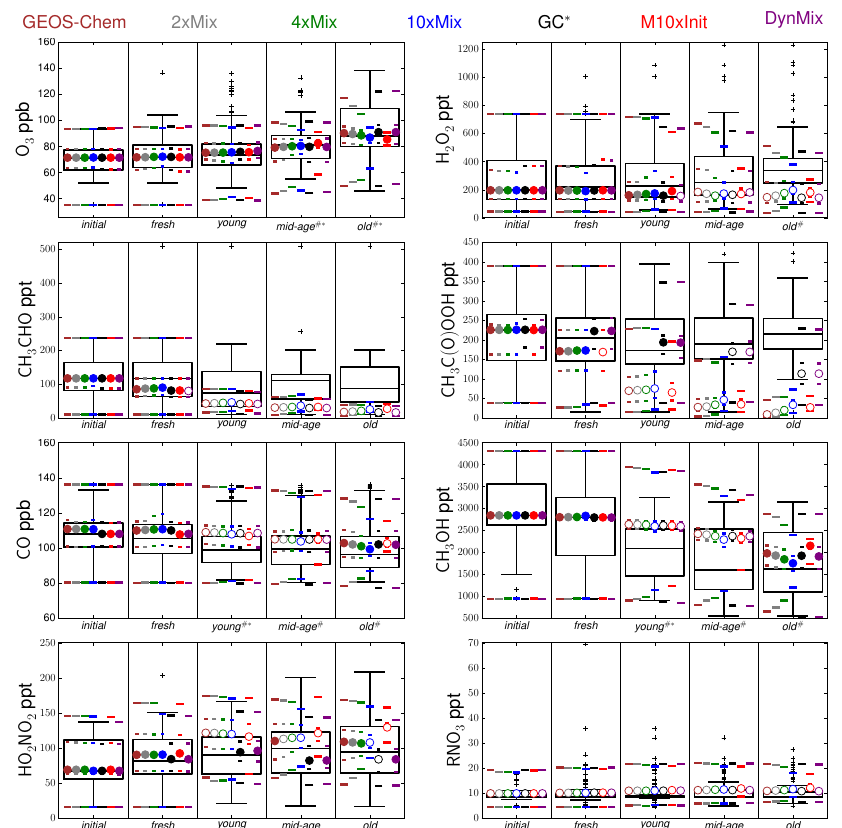
Fig. A3. Same as Fig. 5, but for GEOS-Chem with standard and alternate background mixing.